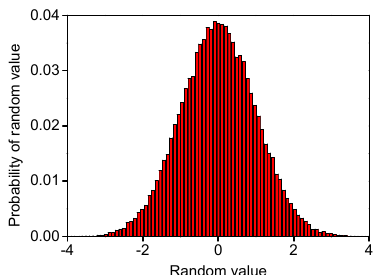
Figure 4. Random values with Gauss distribution.